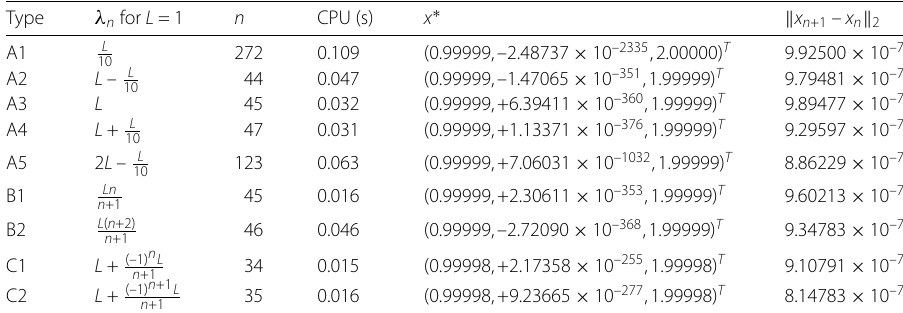
Table 3 Numerical results of Example 4.8 for the initial points x 0 = (1,–2,–1) T and x 1 = (–2,–1,2) T using the algorithm in Theorem